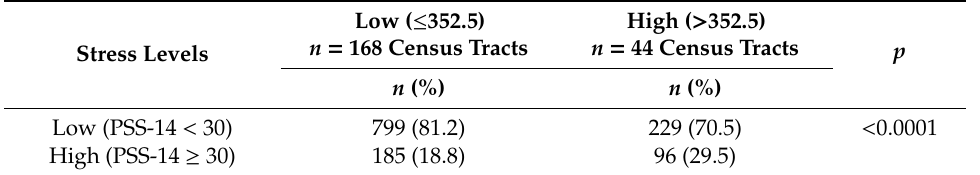
Table3. Neighborhoodviolentcrimeincidentspersquarekilometerandperceivedstress( Motherhoodand Microbiome cohort, n = 1309).